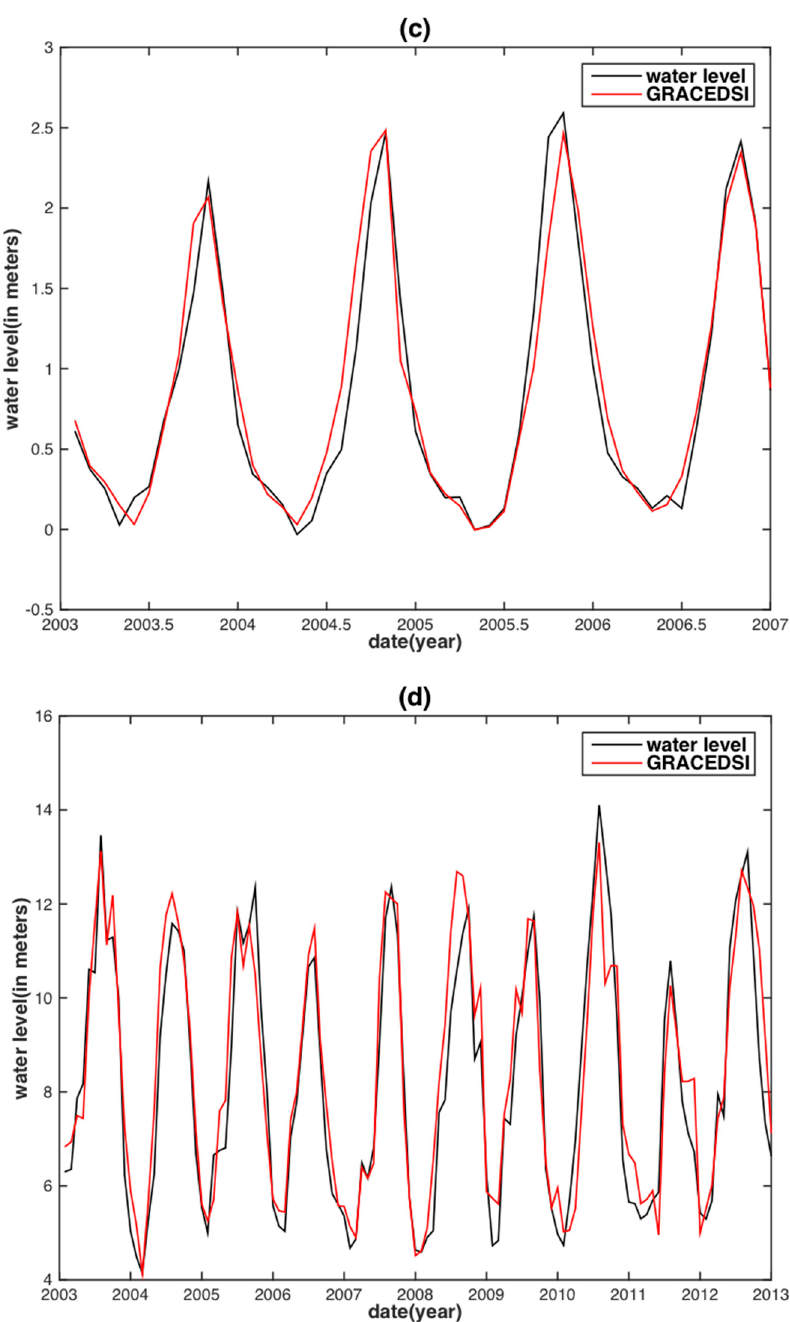
Figure 7. Time series of GRACE-DSI values against the standardized water level in MRB ( a ) and YRB ( b ); GRACE-DSI reconstructed water level against the observed water level in MRB ( c ) and YRB ( d ).